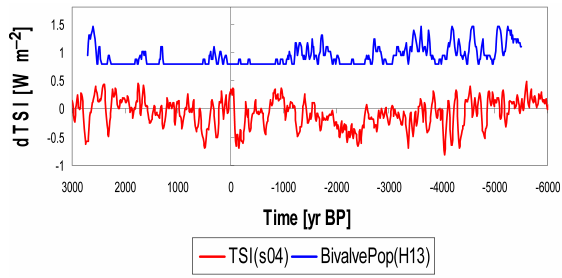
Figure A1. Comparison of bivalve population (BVp) and TSI. A linear transformation [BVp(H13) = aBVp(H13) + b ] with a factor a = 0 . 22 and a bias b = 0 . 84.